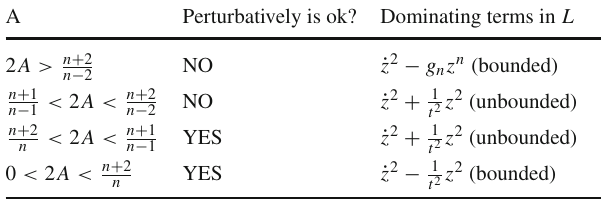
Table 1 Summary of results for the interacting models ( n even, n ≥ 4) A Perturbatively is ok? Dominating terms in